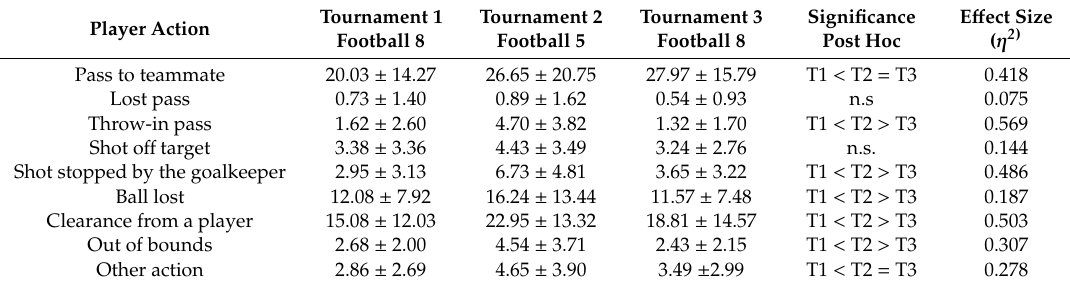
Table 5. Technical-tactical actions by which players end ball possession.